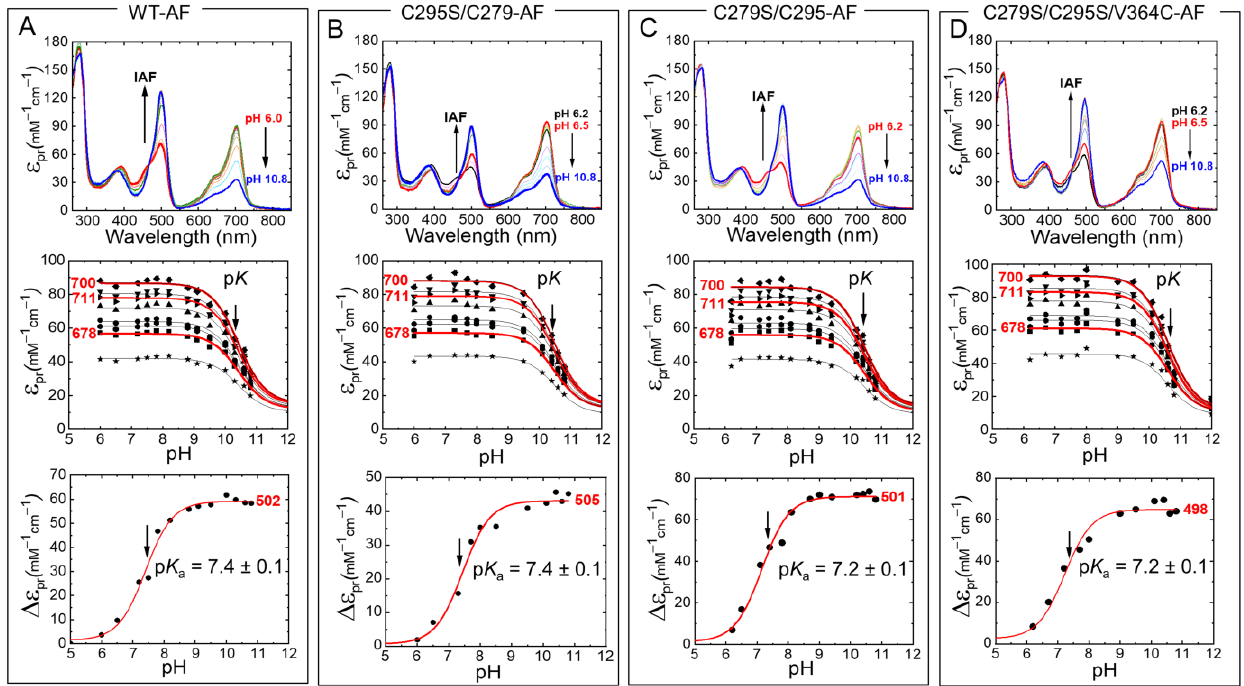
Figure 6. pH-dependent Pr absorption spectra of IAF-labeled Agp1-PGP and its variants (top panel). ( A ) WT-AF, ( B ) C295S/C279-AF, ( C ) C279S/C295-AF, ( D ) C279S/C295S/V364C-AF. The direction of the pH titration is indicated by the black arrow. The middle panel shows the respective titration data at nine wavelengths 678 ( ■ ), 683.5 (●), 689 ( ▲ ), 694.5 ( ▼ ), 700 ( ⧫ ), 705.5 ( ◄ ), 711 ( ► ), 716.5 ( ⬣ ), and 722 nm ( ★ ). Selected fit curves at 678, 700, and 711 nm are marked in red. The bottom panel shows the respective titration data at the absorption maxima of the pH-sensitive absorption band of fluorescein with 502 nm ( A ), 505 nm ( B ), 501 nm ( C ), and 498 nm ( D ). The pH-dependence was fitted by the Henderson−Hasselbalch equation (Equation (2)) using Origin Pro 2019 (Origin Lab). The fit results for the middle panels are summarized in Table 1, the p K a values for bound fluorescein are indicated in the figures. The absorption of the deprotonated chromophore at high pH was estimated to 20% of the maximum absorption of the respective wavelength. Conditions: 300 mM NaCl, 50 mM Tris/HCl buffer for pH 6.2–9.5, or 100 mM Na 2 CO 3 /NaHCO 3 buffer for pH 9.5–10.8, at 20 °C.